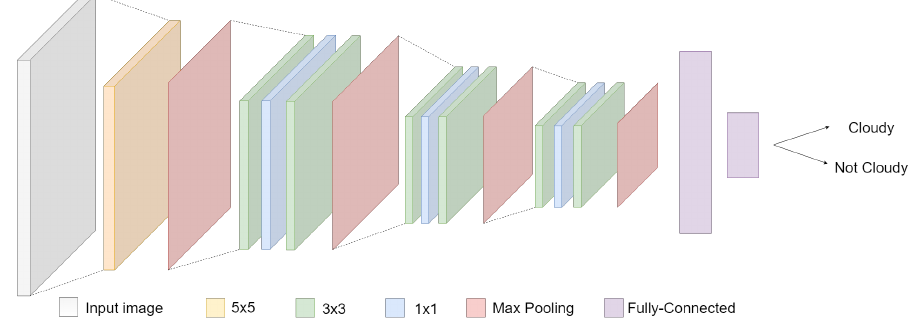
Figure 1. CloudScout Model